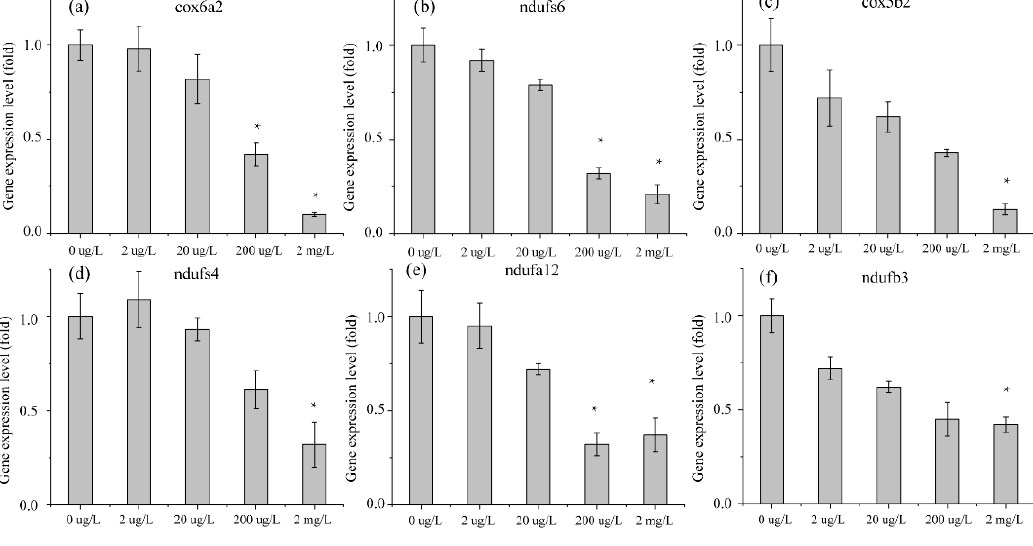
Figure 8. The effects of erythromycin on the mRNA expression of genes in D. rerio and O. latipes . (( a – c ) gene in D. rerio ’s muscle; ( d – f ) gene in O. latipes ’s muscle; ( g – i ) gene in D. rerio ’s head; ( j – l ) gene in O. latipes ’s head) Values represent the mean ± SD (n = 3 replicates). * indicates p < 0.05 relative to the control. 4. Discussion 4.1. Swimming Performance Antibiotics had a greater negative effect on the U crit of D. rerio than on that of O. latipes . The U crit of both species was significantly impaired at high exposure concentrations. Other environmental pollutants have been shown to reduce the swimming ability of other species of fish. For example, the U crit of juvenile Florida pompano was significantly reduced from 90.10 ± 1.35 cm/s to 84.20 ± 1.36 cm/s under the toxic influence of methanol [24]. Another study found that U crit of Erimyzon sucetta was reduced by approximately 50% when they were exposed to ash [25]. Prolonged swimming activities (such as U crit ) may be sensitive to changes in maximum aerobic capacity, cardiac output, muscle fiber function, and anaerobic metabolism. The results showed that the aerobic capacity of the fish was impaired. There are several possible reasons for this impairment. Fish are poisoned by environmental pollutants and are forced to detoxify a large amount of oxygen [26,27], which reduces the oxygen supplied for exercise [27]. In addition, water pollution can change the shape of gill tissue, resulting in an impaired tissue oxygen supply during exercise [28,29]. Moreover, sublethal exposure to contaminating elements can also lead to increased hemoglobin and plasma protein concentrations, resulting in increased blood concentrations and local tissue hypoxia [30].